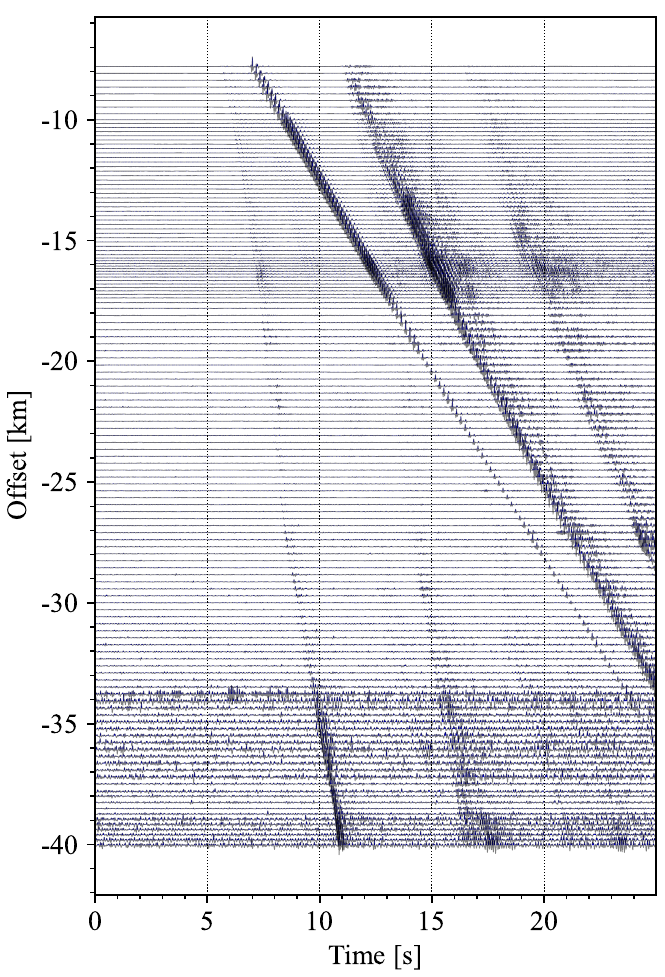
Figure 5. Seismic section, including 135 traces. All traces are normalized separately to their respective absolute maximum.